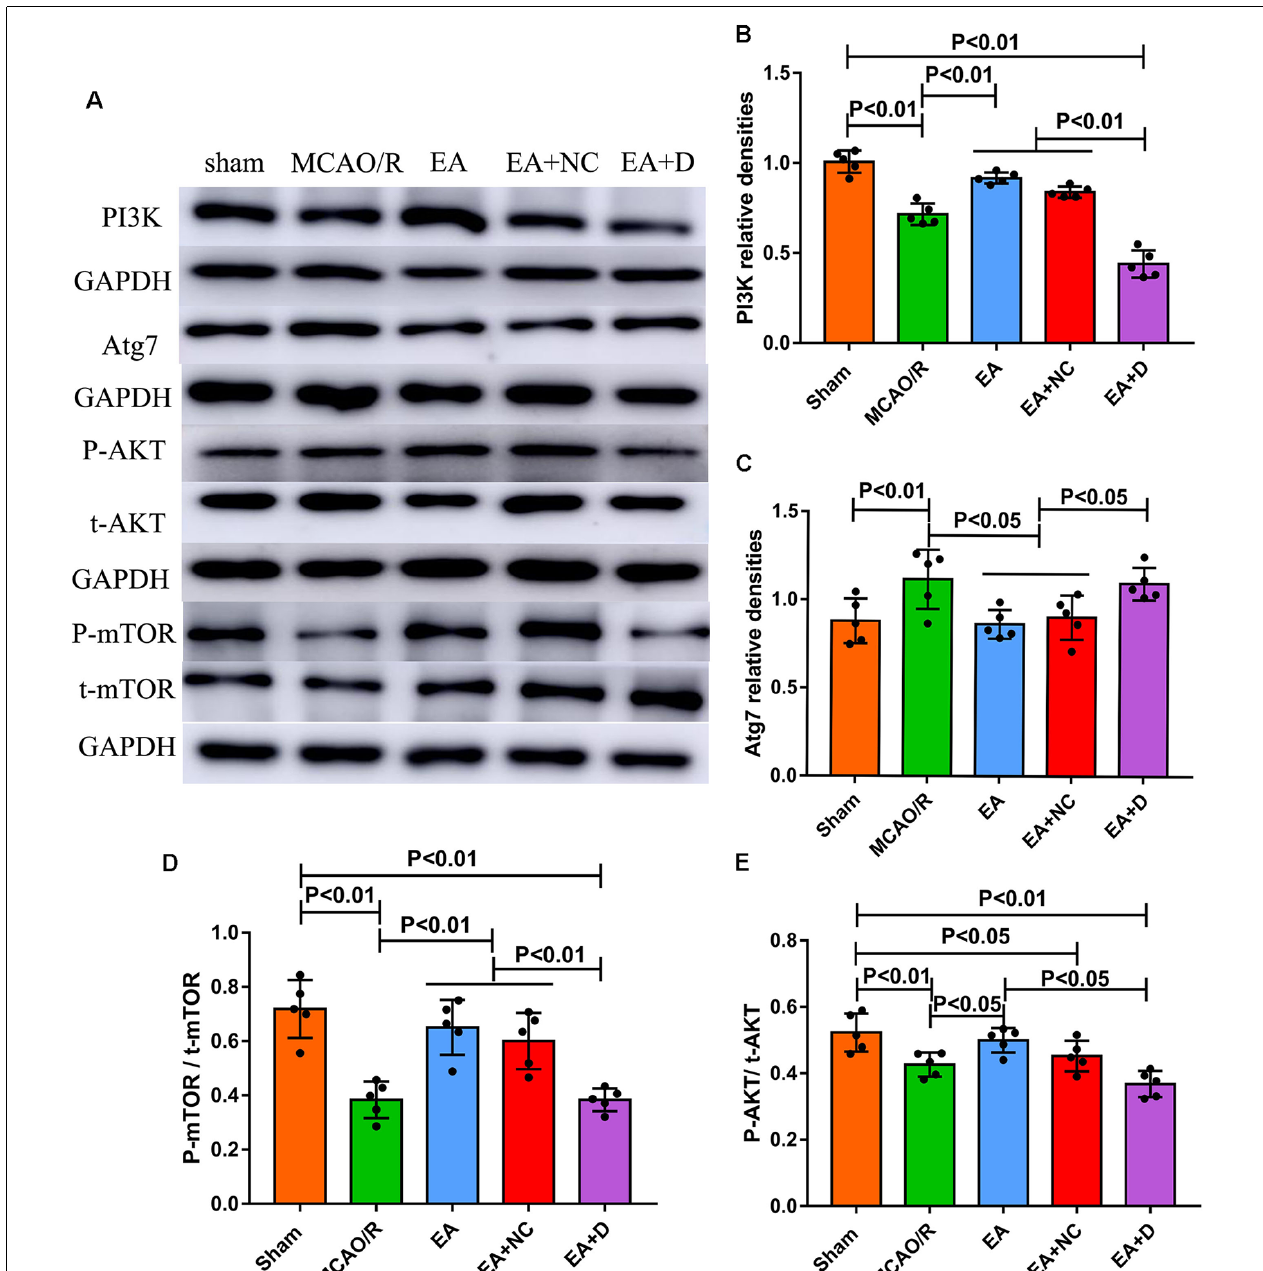
FIGURE 4 | Effect of EA intervention on the protein of the PI3K/AKT pathway in cerebral I/R-injured rats. (A) Western blot analysis showing the levels of PI3K, Atg7, P-AKT, t-AKT, P-mTOR, and t-mTOR among the sham, MCAO/R, EA, EA+NC, and EA+D groups. (B) Statistical analysis showing the difference of PI3K in the ipsilateral hippocampus of the rats ( n = 5/group). (C) Statistical analysis showing the expression of Atg7 in the ipsilateral hippocampus of the rats. (D) Statistical analysis showing the level of P-mTOR/t-mTOR in the ipsilateral hippocampus of the rats. (E) Statistical analysis showing the level of P-AKT/t-AKT in the ipsilateral hippocampus of the